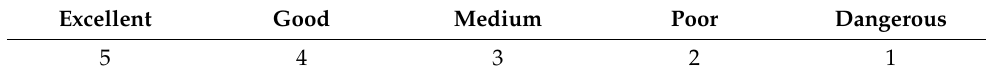
Table 2. Levels of cyber security situation.